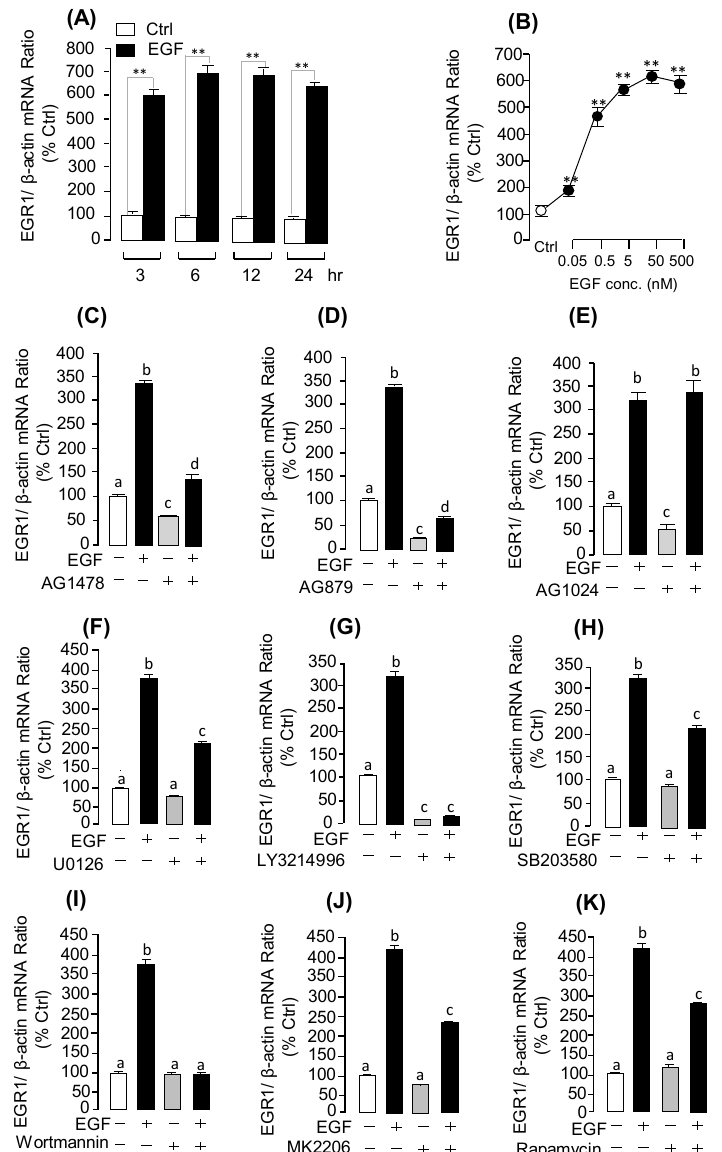
Figure 4. EGF induced EGR1 mRNA expression in grass carp pituitary cells, including receptor specificity and signal transduction pathways. ( A ) In the time course experiment, pituitary cells were treated with EGF (0.5 µ M). ( B ) In the dose experiment, pituitary cells were cultured with EGF (0.05–500 nM). ( C – E ) Receptor specificity of EGF (0.5 µ M)-induced EGR1 mRNA expression; e ff ects of ErbB1 antagonist AG1478 (10 µ M), ErbB2 antagonist AG879 (10 µ M), and IGF receptor antagonist AG1024 (10 µ M) on EGR1 mRNA expression for 24 h, respectively. ( F – H ) Signal transduction of EGR1 mRNA expression induced by EGF (0.5 µ M) in grass carp pituitary cells. The e ff ects of UTS1 mRNA transcription induced by EGF (0.5 µ M) with EGF (0.5 µ M) in the presence or absence of the MEK inhibitor U0126 (10 µ M), ERK1 / 2 inhibitor LY3214996 (10 µ M), or p38MAPK inhibitor SB203580 (10 µ M), respectively. ( I – K ) The e ff ects of EGF (0.5 µ M) induced EGR1 mRNA expression with the PI 3 K inhibitor Wortmannin (10 µ M), AKT inhibitor MK2206 (10 µ M), or mTOR inhibitor Rapamycin (10 µ M) by EGF (0.5 µ M)-induced EGR1 mRNA expression for 24 h, respectively. After drug treatment, total RNA was isolated and used for real-time PCR of UTS1 mRNA expression. The di ff erences between groups were considered as highly significant at p < 0.01 (“**”). The groups denoted by di ff erent letters represent a significant di ff erence at p < 0.05.